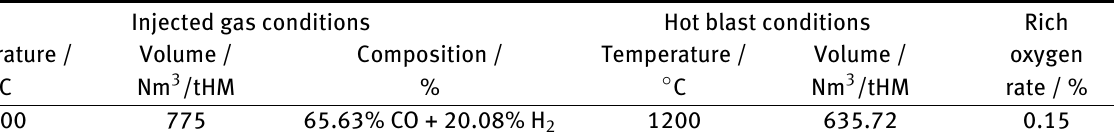
Table 5: Optimum parameters of a lower operation schedule in the gas-injection BF